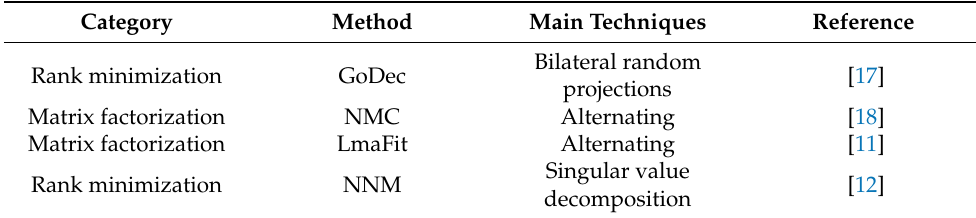
Table 1. Specifications of conventional matrix completion algorithms evaluated in this